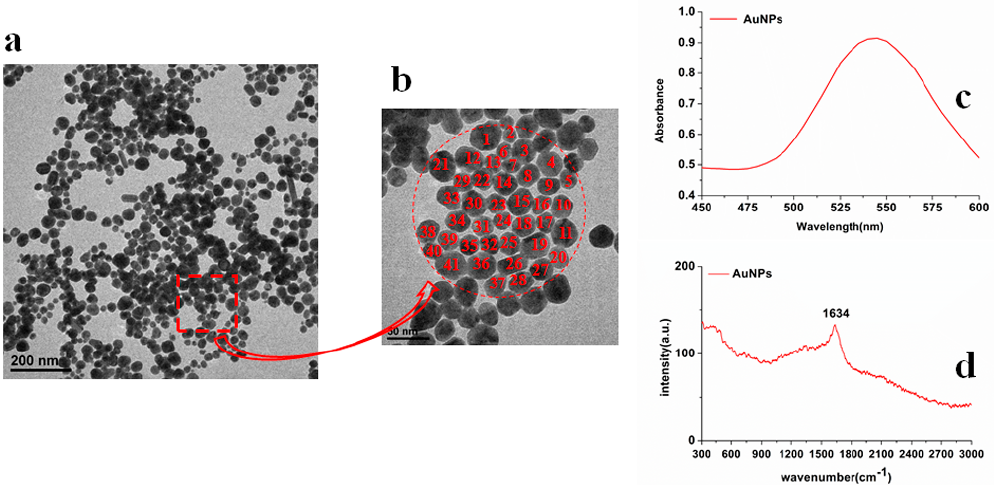
Figure 3. Transmission electron microscopy (TEM) images of: ( a ) AuNPs (200 nm scale) and ( b ) AuNPs (50 nm scale); ( c ) the UV/Visible spectra of AuNPs; ( d ) the SERS of AuNPs.